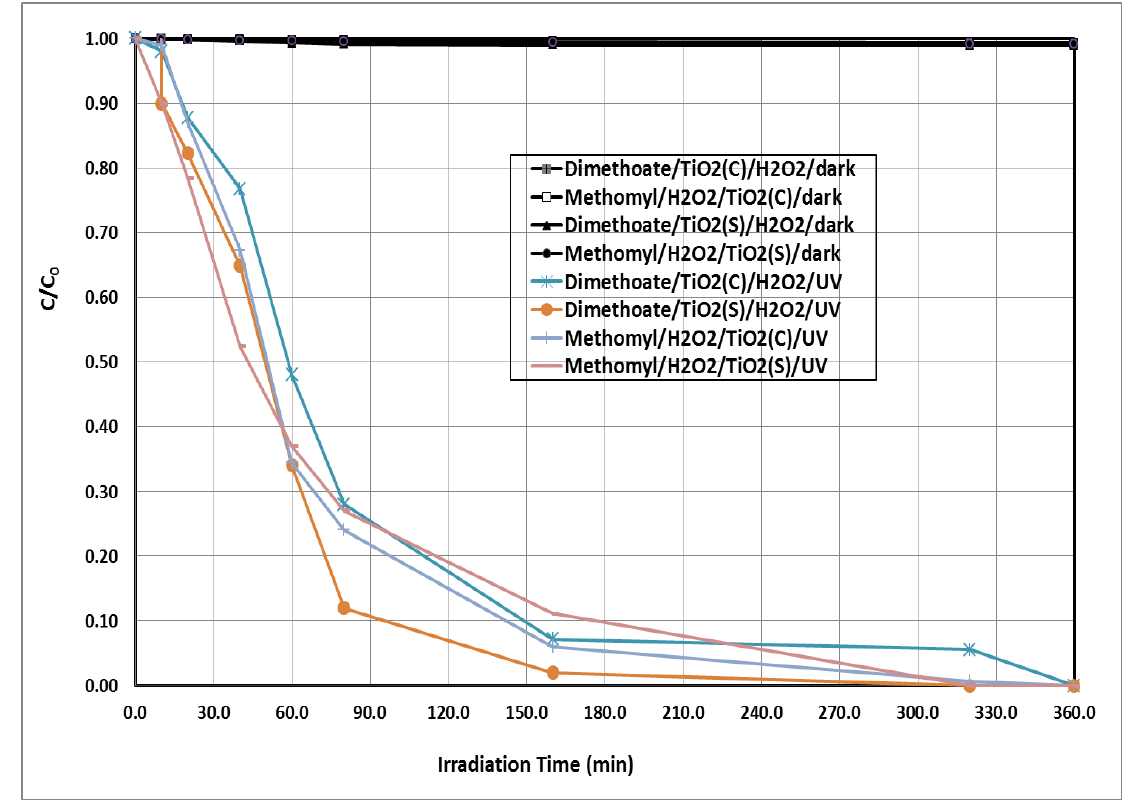
Figure 1. Photochemical degradation of the tested insecticides at initial concentration of 5 ppm using TiO 2 (c)/H 2 O 2 /UV and TiO 2 (s)/H 2 O 2 /UV. H 2 O 2 = 20 mg/L, TiO 2 = 300 mg/L, pH = 7. C= concentration at t time, C 0 = initial concentration at zero time.